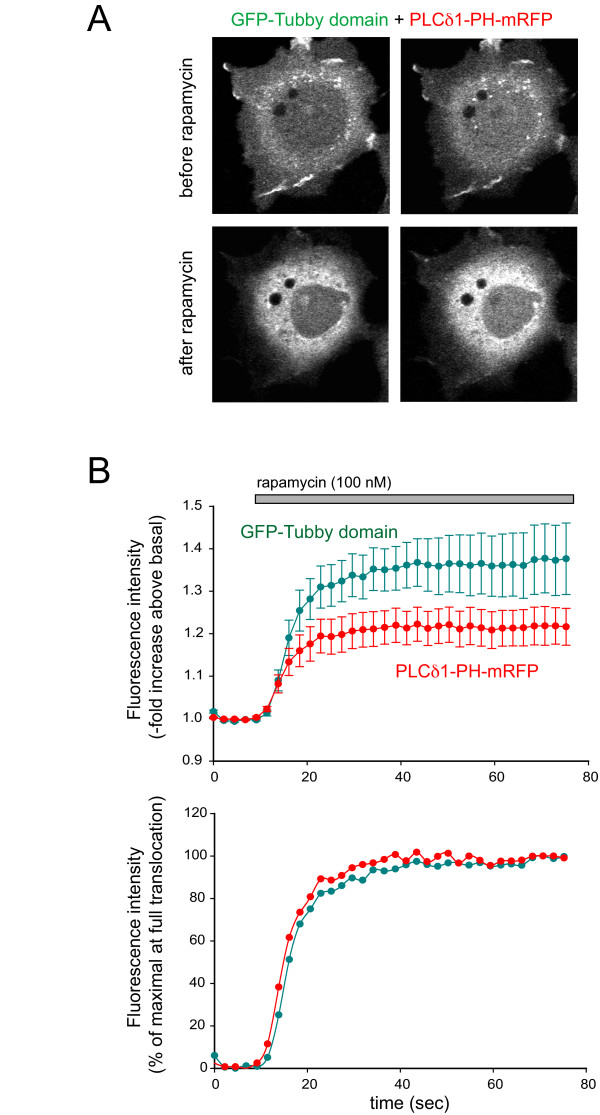
Translocation responses of the Tubby domain and PLCδ1PH domain after rapid dephosphorylation of PtdIns(4,5)P2 at the PM. COS-7 cells were co-transfected with the PM-targeted FRB tagged with CFP (not shown), the type-IV 5-ptase domain tagged with cerulean (not shown), the GFP-Tubby-domain and PLCδ1PH-mRFP. After 24 h, live cells were analyzed by confocal microscopy. Addition of 100 nM rapamycin induces translocation of the 5-ptase to the PM, causing a complete loss of both PtdIns(4,5)P2 reporter localization. Panel A shows representative images before and after rapamycin addition. Panel B shows a full time course of cytoplasmic fluorescence intensity changes based on the average of 10 cells (Mean ± S.E.M.) expressed as a -fold increase over initial values (upper) or as a percent of the maximal response (lower panel, means are shown only).